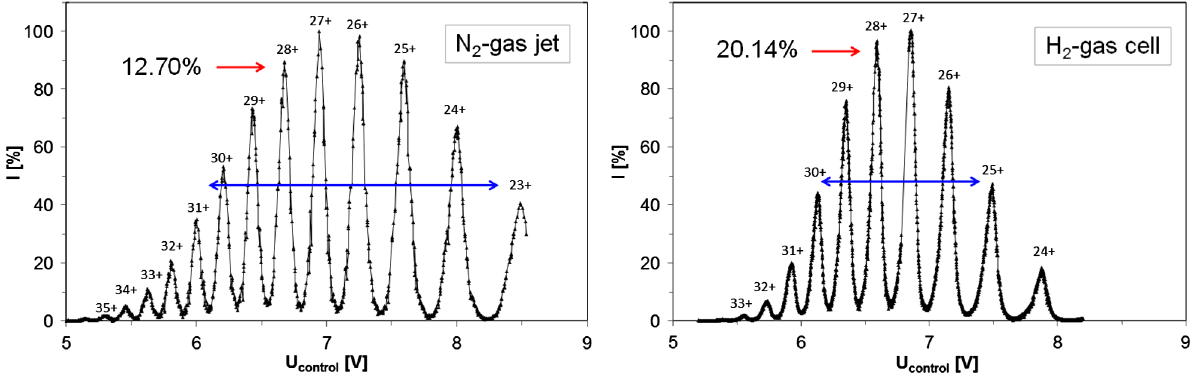
FIG. 5. N 2 -gas jet (left) and H 2 -pulsed gas cell charge spectra for maximum available target density.